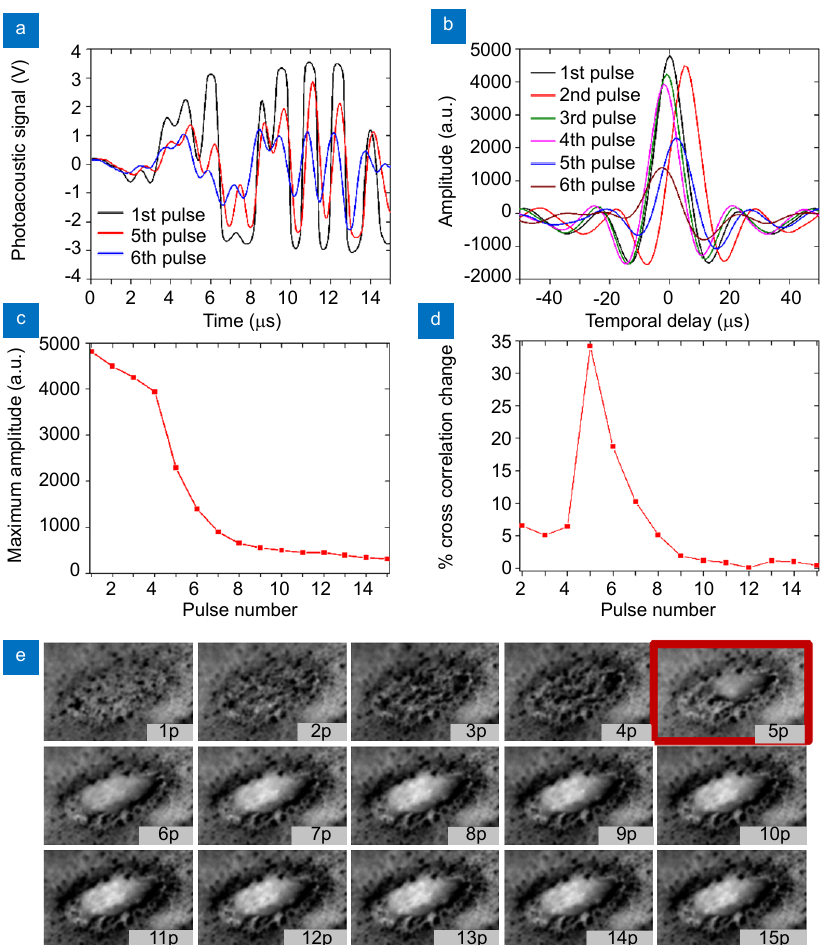
Fig. 2 | ( a ) Recorded PA waveform for F IR =0.8 J/cm 2 at 1st, 5th and 6th laser pulse respectively. ( b ) Cross correlation of PA waveforms generated after the incidence of N th and 1st pulse. ( c ) Maximum amplitude of cross correlation operation calculated for the first 15 laser pulses. ( d ) Per- centage change of cross correlation maximum amplitude. The peak indicates the pulse at which the marble substrate has been reached. ( e ) Optical images recorded for the first 15 laser pulses. Red margin indicates the point where the maximum change has been observed according to Fig.